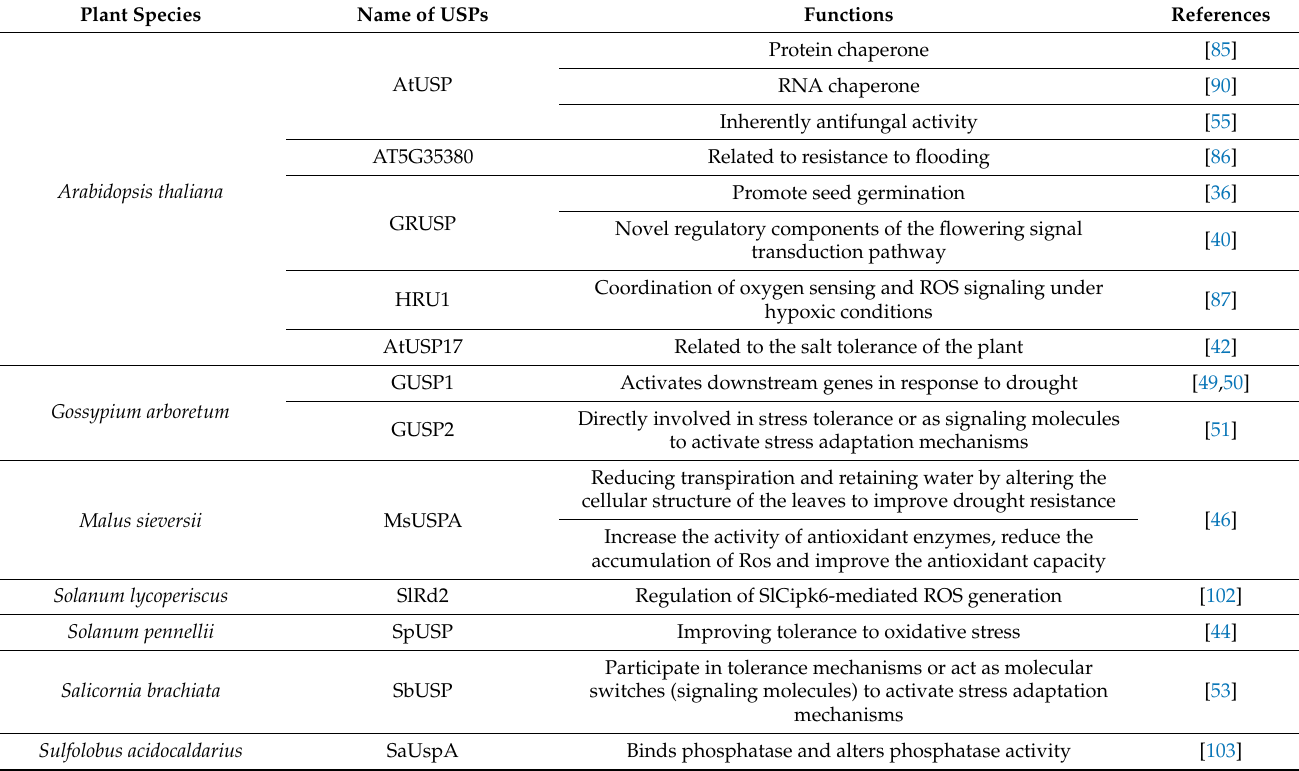
Table 3. Summary of the functions of USPs in different